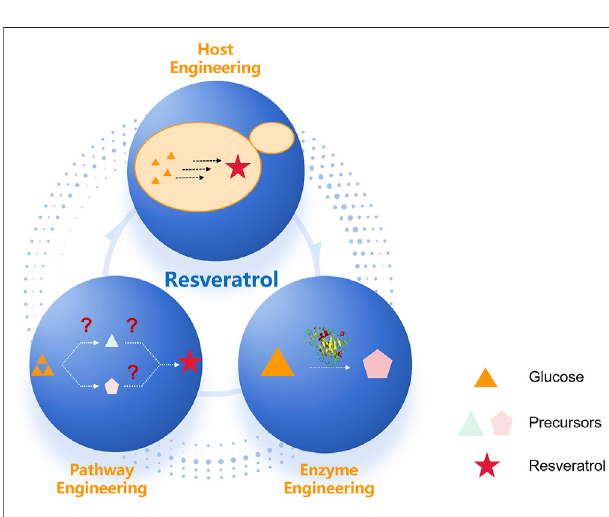
FIGURE 2 | Metabolic engineering at multiple levels has enabled engineering of increasingly complex heterologous resveratrol pathways. Heterologous resveratrol production in a microbial host can involve engineering at three different scales: host, pathway, and